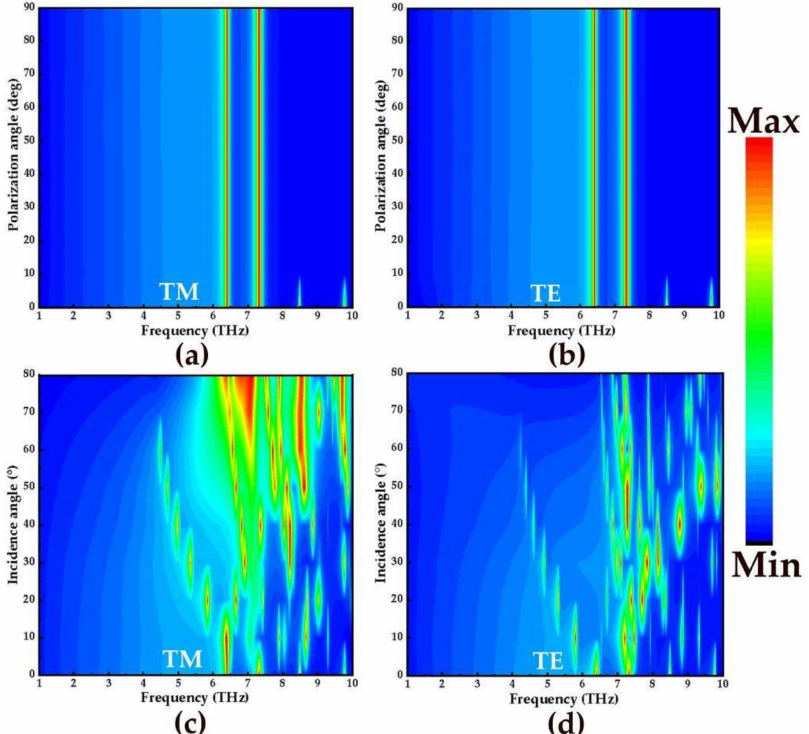
Figure 8. The absorption spectra of narrowband absorbers in TM and TE mode: ( a , b ) different polarization angles; ( c , d ) different incident